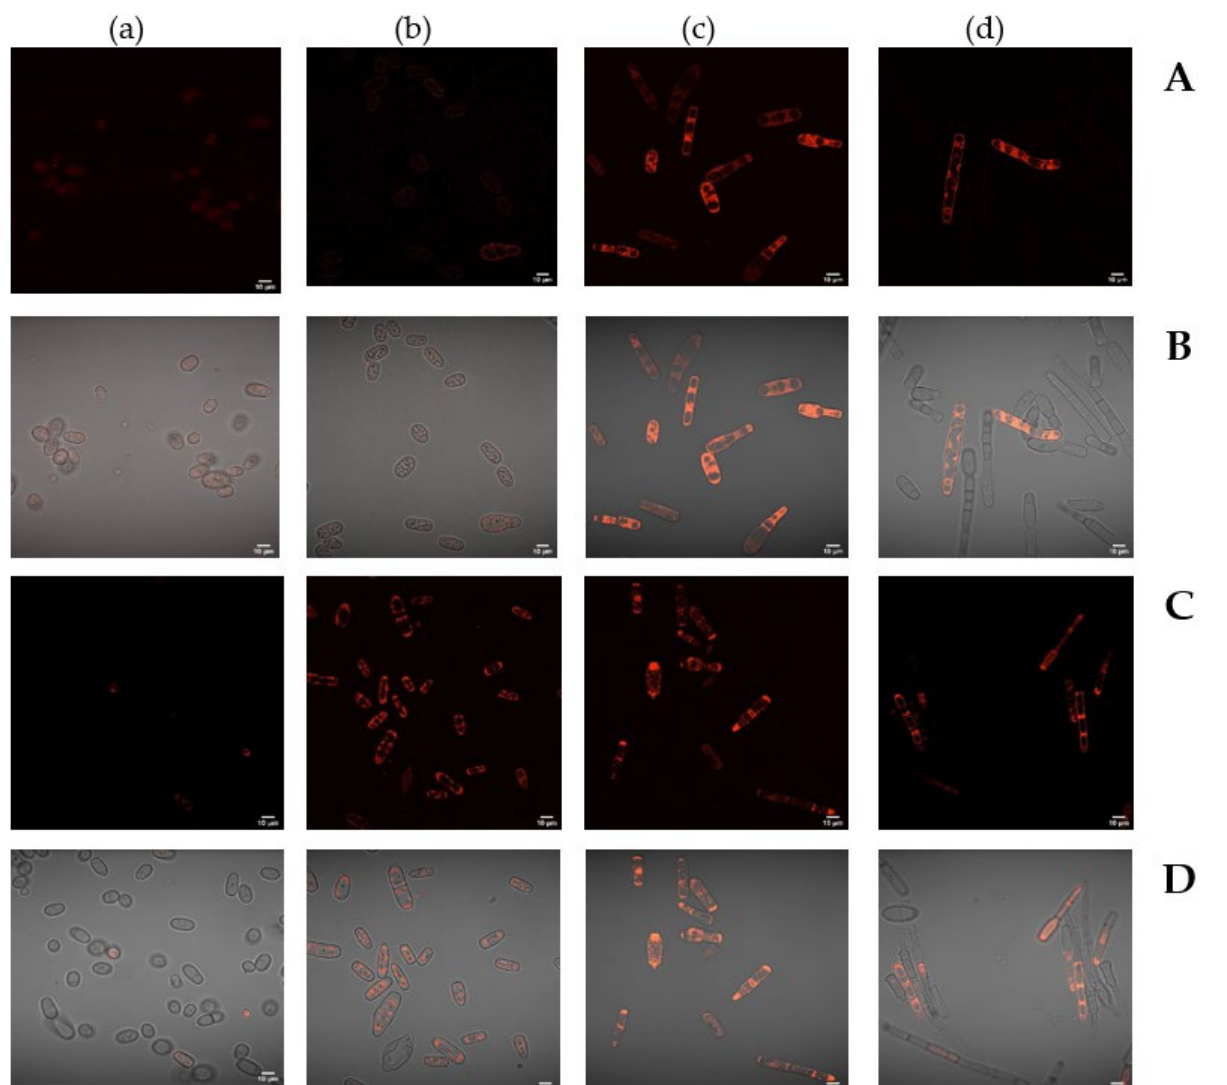
Figure 10. The visualization of the lysosomes after staining with LysoTracker Red DND-99. ( A , B ) is one-week stage; ( C , D ) four-week stage. ( A , C ) Fluorescent microscopy; ( B , D ) optical and fluorescent images. ( a )—glycerol 2%; ( b )—glucose 2%; ( c )—glucose 0.5%; ( d )—glucose 0.2%.